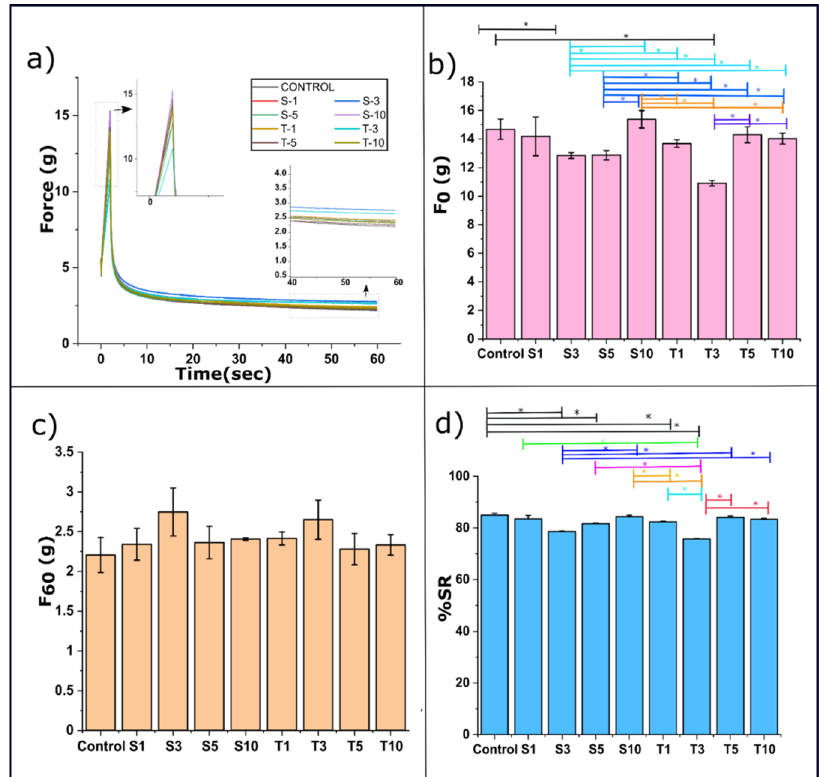
Figure 6. Mechanical properties of the oleogels. ( a ) Stress relaxation profile, ( b ) F 0 values, ( c ) Residual elastic force in oleogels, and ( d ) %SR values. The values in the graph are denoted as the mean of the triplicate ± standard deviation ( p < 0.05). The significantly different values are marked with *. The details of abbreviations used are provided in Section 4.2 (Table